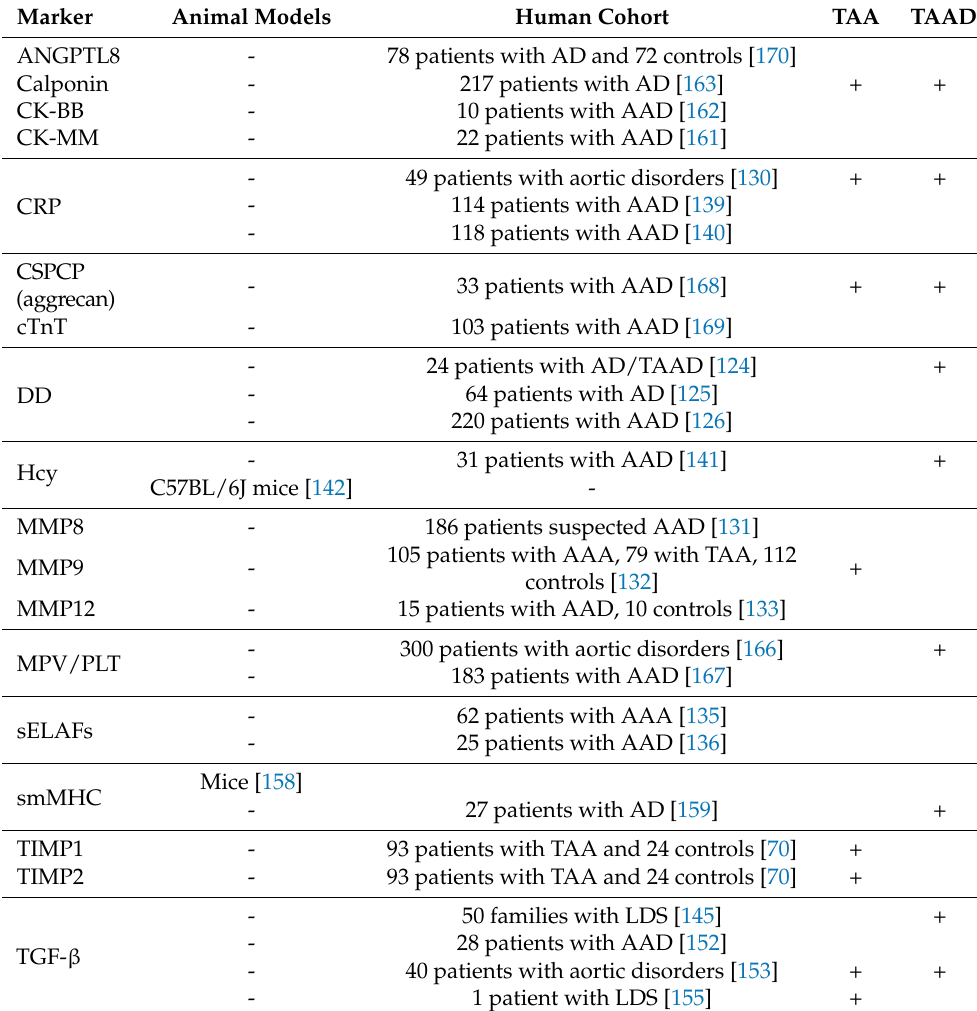
Table 2. Proposed/suggested circulating biomarkers for